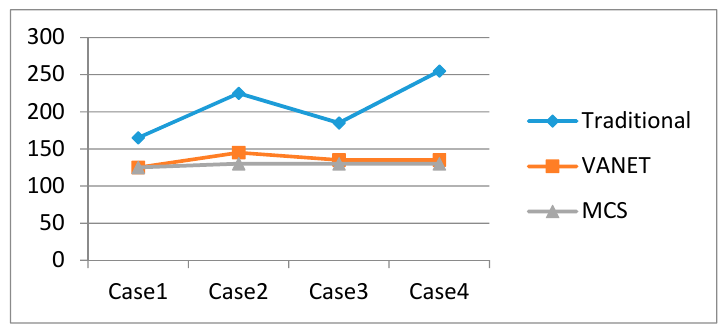
Figure 7. Time taken in the different cases.